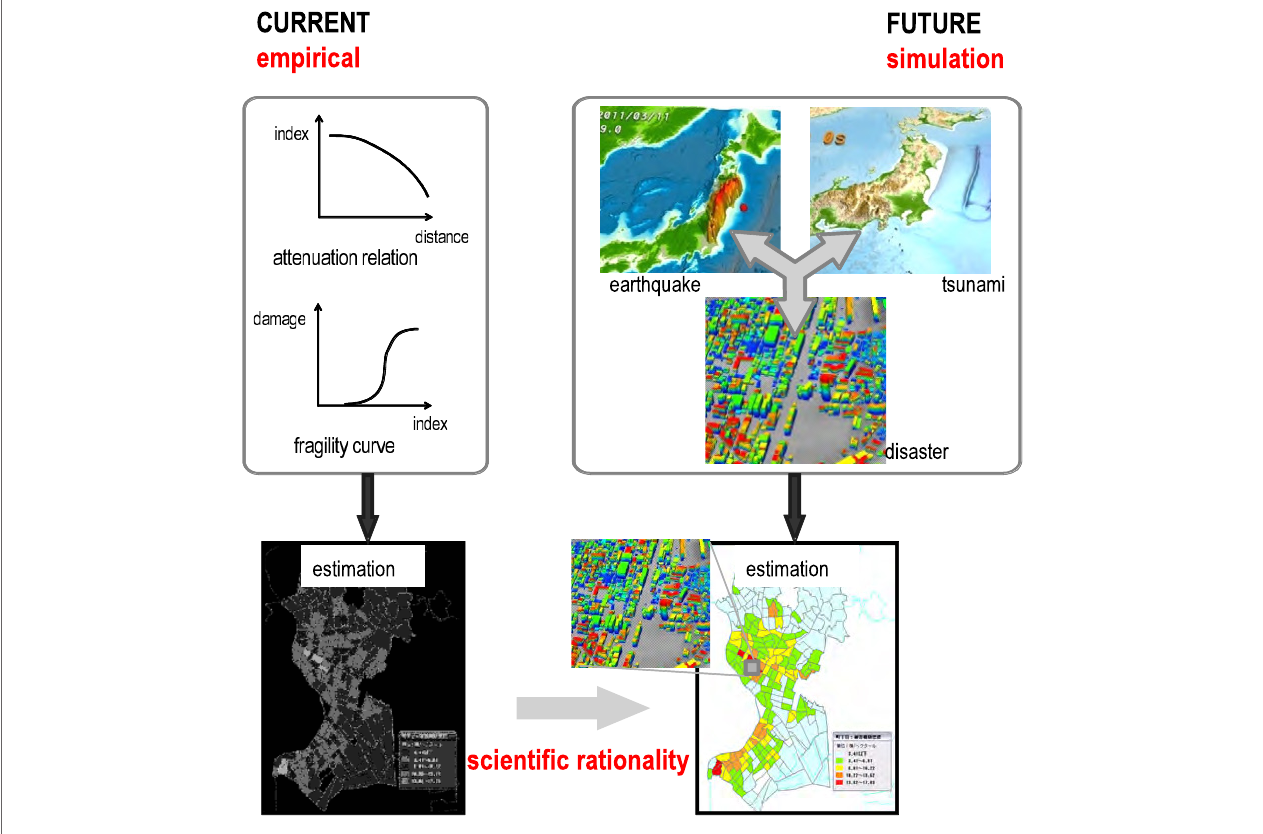
FigUre 1 | Methodology of estimating earthquake hazard and disaster.